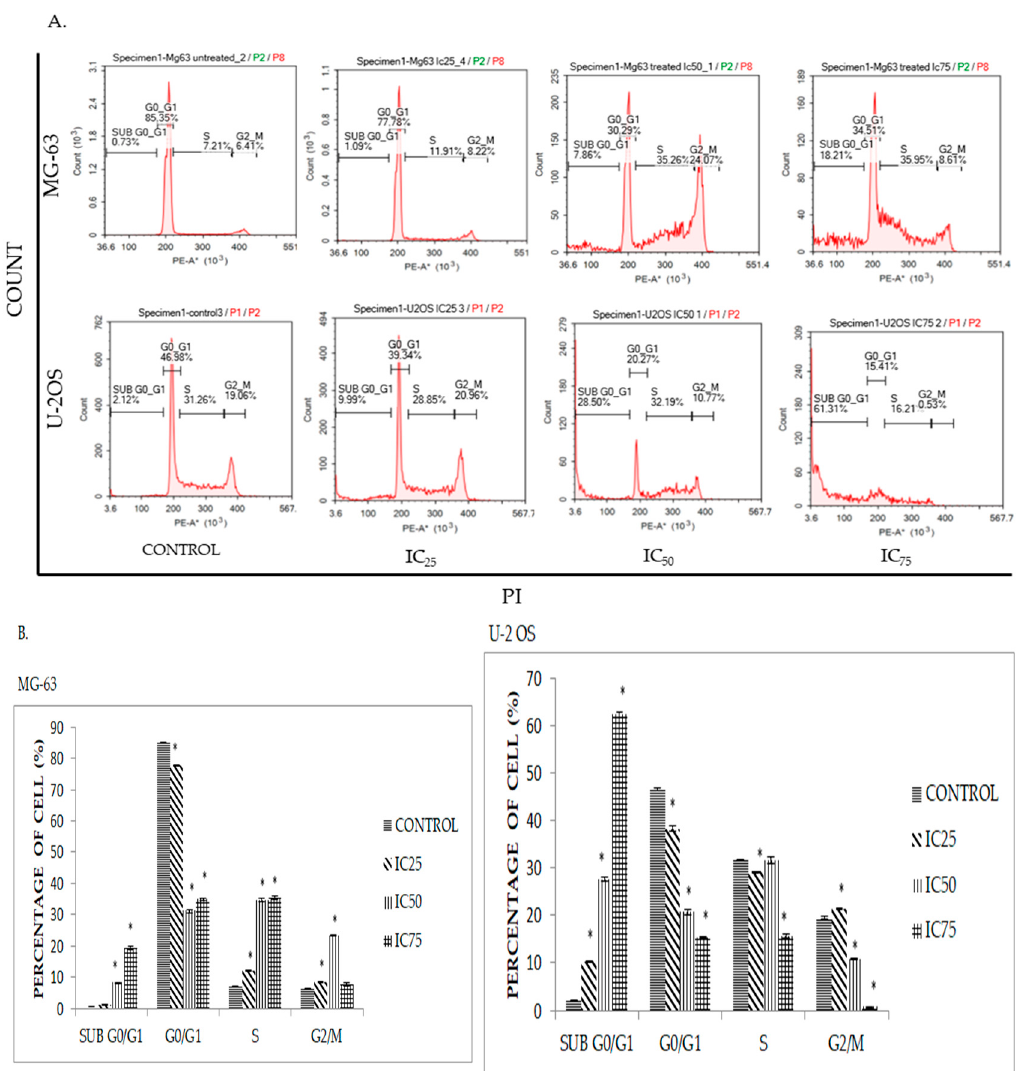
Figure 4. ( A ) Cell cycle histogram analysis for MG-63 and U-2OS after being treated with three different concentrations of DK1 (IC 25 , IC 50 , IC 75 ) at 48 h; ( B ) Quantification analysis of cell cycle distribution for MG-63 and U-2OS when treated with three different concentrations of DK1. All data are expressed as mean ± standard error mean (S.E.M). * p < 0.05 compared with corresponding controls.